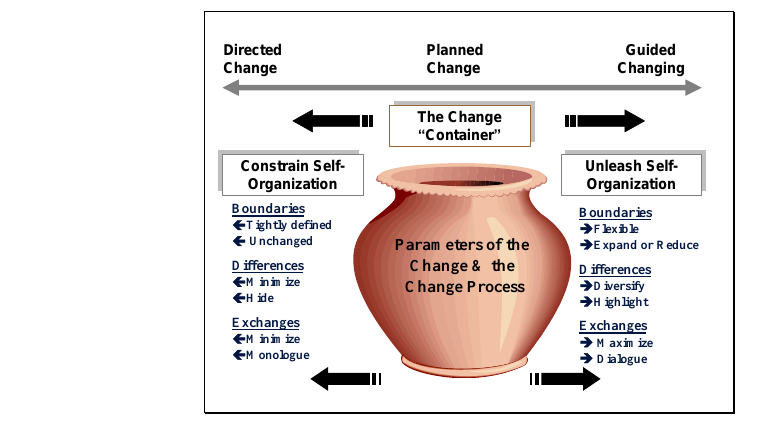
Figure 5: The Change